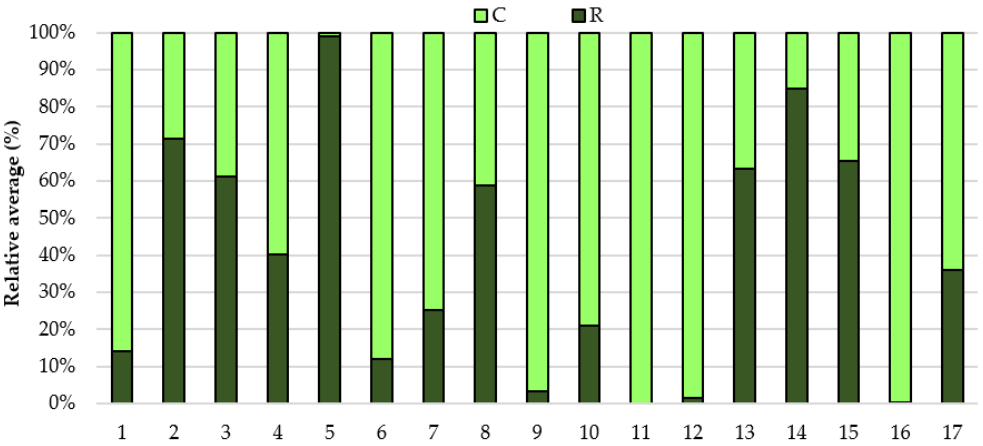
Figure 3. The relative average of the Lactobacillaceae family in the feces of the animals before (C) and after race (R).